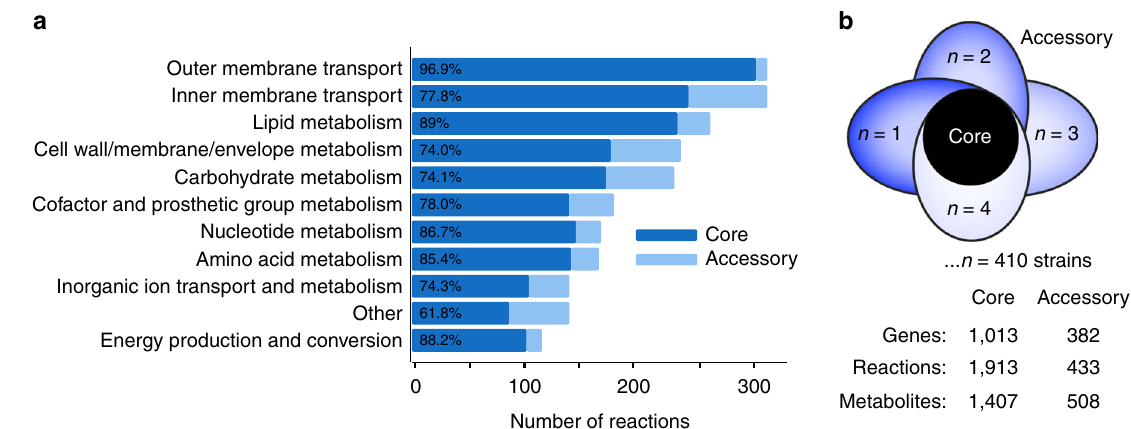
Fig. 2 Salmonella pan reactome. a Reaction distribution per functional category in the 410 genome-scale models (GEMs) of Salmonella strains. The functional categories are de fi ned by the clusters of orthologous groups ontology 64 and classify the metabolic reactions per subsystem. The reactome distribution across metabolic subsystems shows that inner membrane transport, carbohydrate and lipid metabolism constitute the largest portion of the pan reactome. The percentages shown represent the percentage of conserved metabolic processes in each functional category. b Number of core genes, reactions, and metabolites in 410 GEMs of Salmonella . A reaction, gene or metabolite is considered to be part of the core if present in all Salmonella